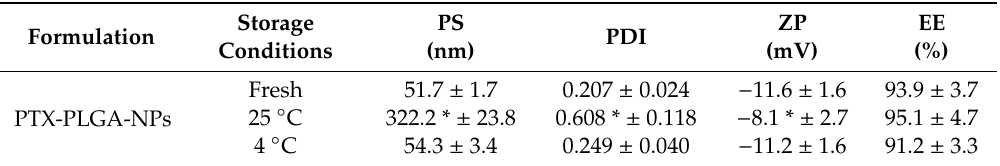
Table 6. Mean ± (SD) particle size (PS), polydispersity index (PDI), zeta potential (ZP) and entrapment e ffi ciency (EE%) of the optimal PTX-PLGA-NPs formulation after 15 days storage at room temperature and 4 ◦